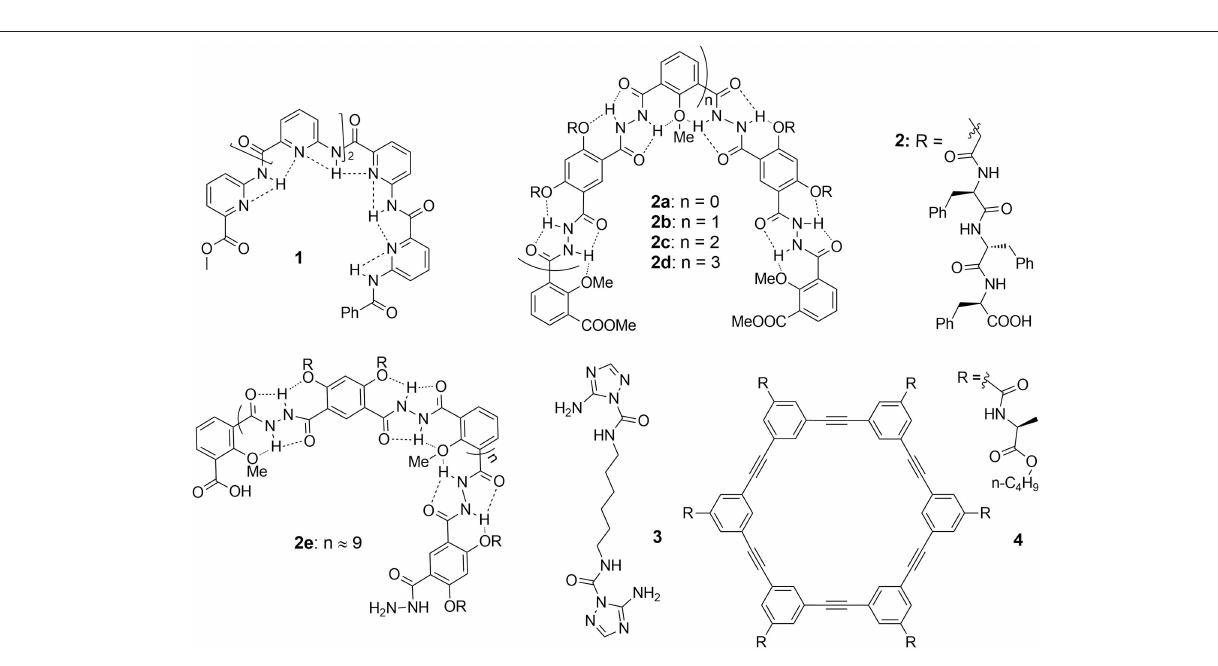
FIGURE 1 | Artificial Gramicidin A ion channel forming compounds: aromatic foldameric polyamide 1 , aromatic foldameric hydrazides 2a – 2e . bola-amphiphile triazole 3 and arylene-ethynylene macrocycle 4